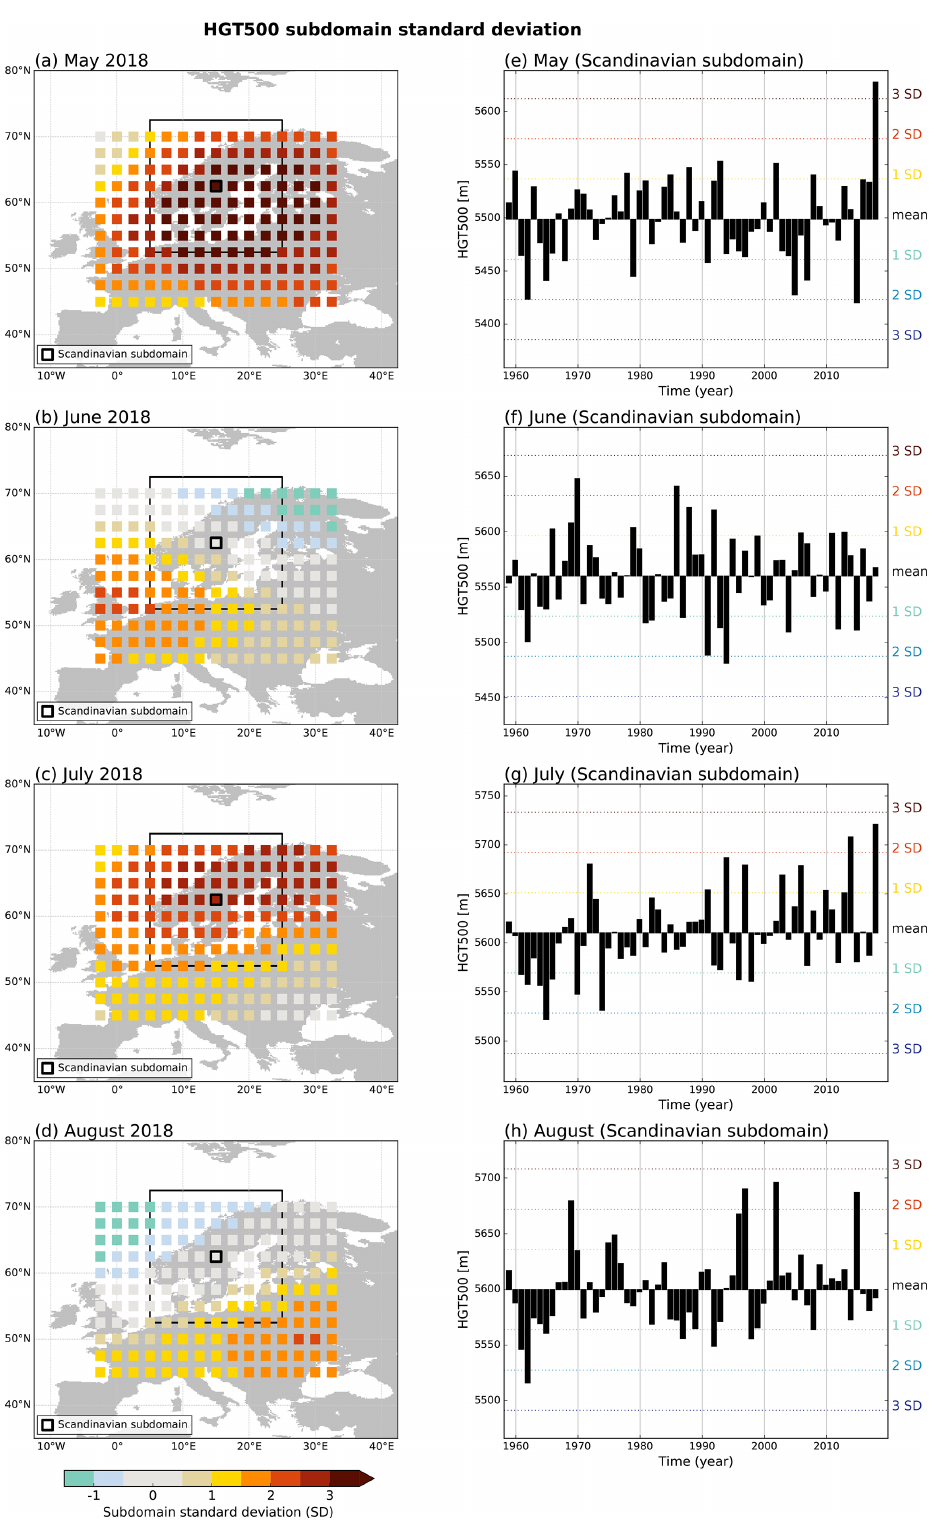
Figure A3. Left panels: geopotential height at 500mbar (HGT500) shown as standard deviation (SD) of (a) May, (b) June, (c) July, and (d) August 2018 based on the 60-year period (1959–2018) for subdomains of 20 ◦ longitude × 20 ◦ latitude throughout Europe, shifted 2.5 ◦ at a time. The coloured squares are the centre points of each subdomain. This is illustrated for one subdomain over Scandinavia, with a large and a small square marking the subdomain’s border and centre point, respectively. Right panels: HGT500 1959–2018 time series of (e) May, (f) June, (g) July, and (h) August for the Scandinavian subdomain. Note the different ranges of the y